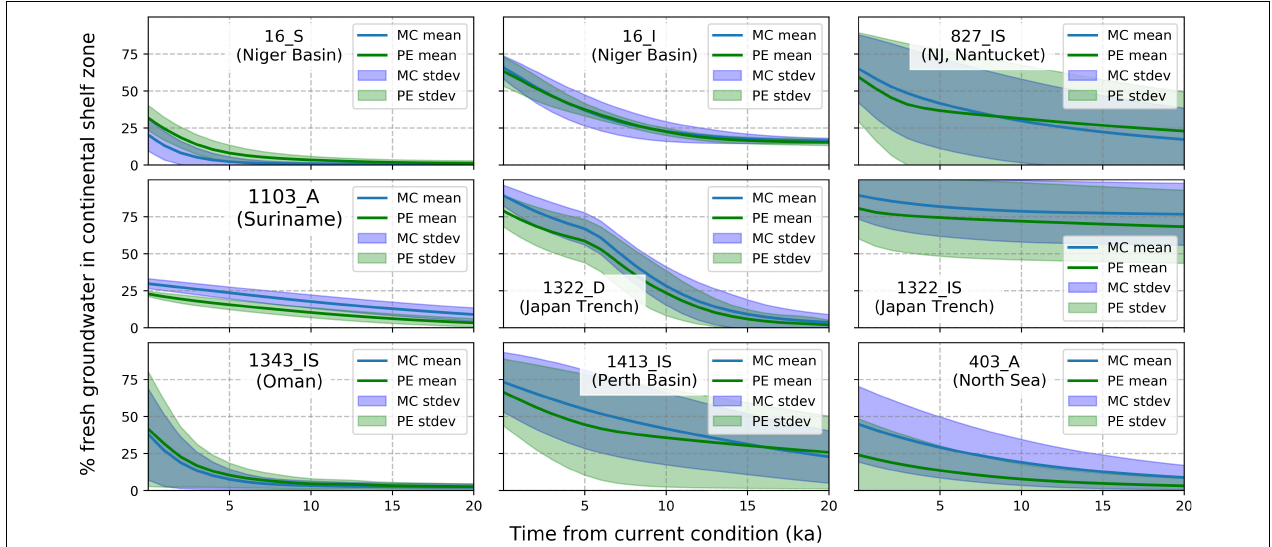
FIGURE 11 | Estimated FGFs in the continental shelf domain for selected COSCAT regions (and respective coastal types) and both modeling concepts during the SP31_DSP time period. The current condition represents the estimated fractions at present time (here year =